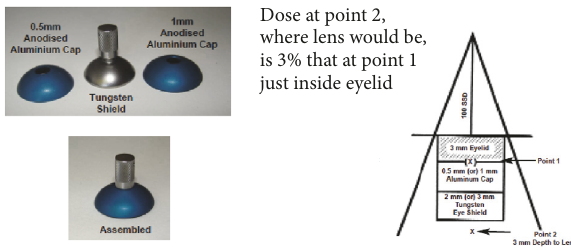
Figure 13: Internal eye shield design.